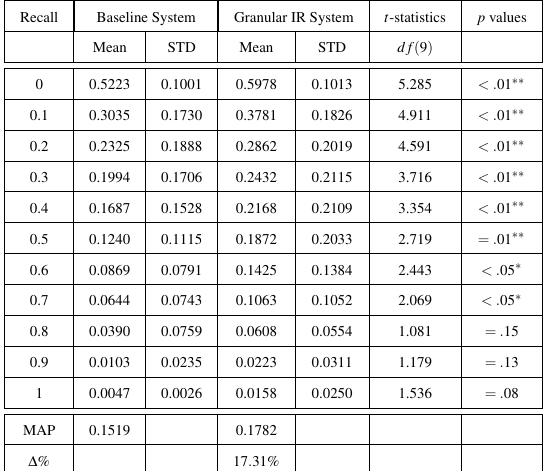
Table 1. Results of the TREC-AP Benchmark